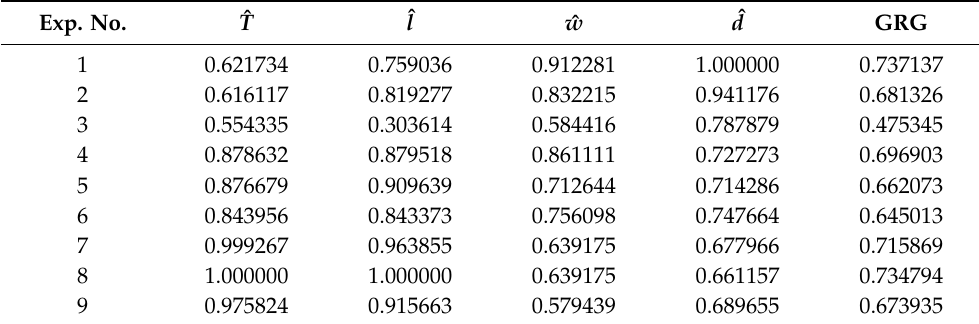
Table 5. Normalized value of simulation results and grey relation grade. Exp.